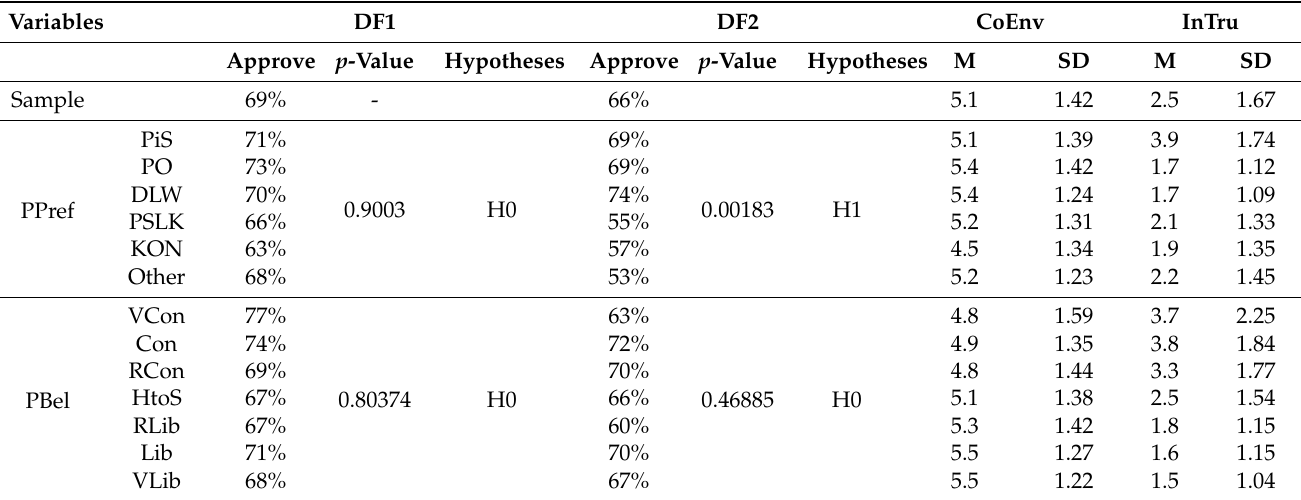
Table 5. Results: political